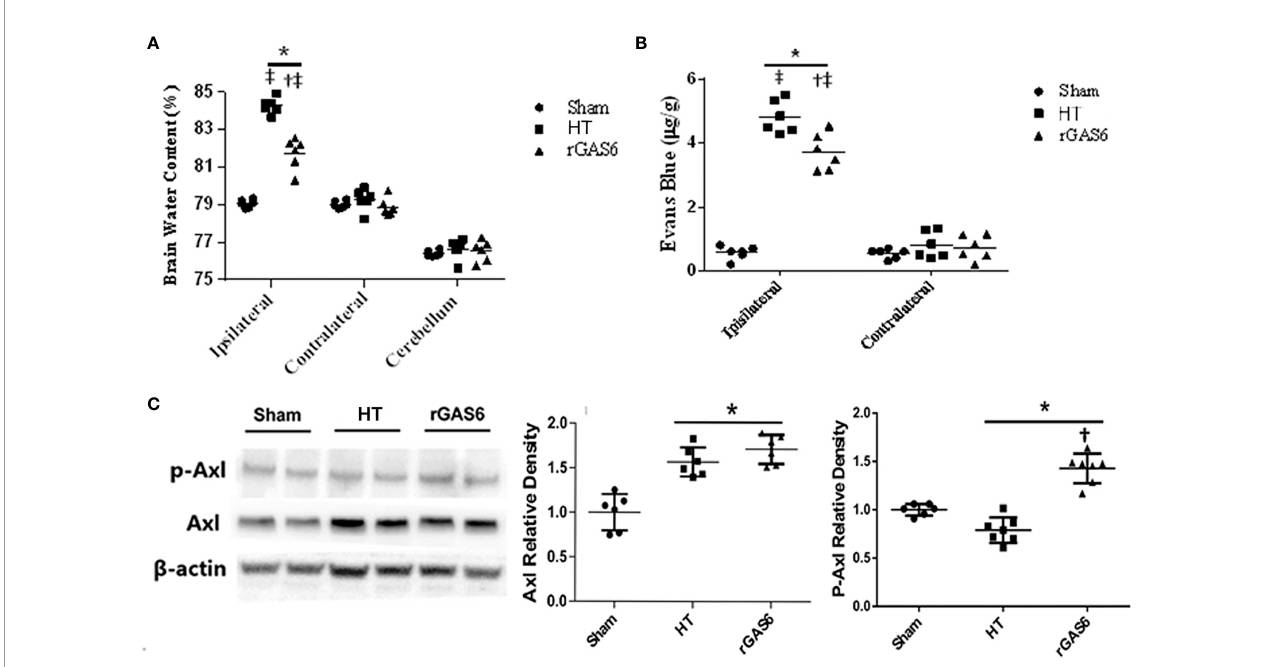
FIGURE 3 | Recombinant GAS6 (rGAS6) treatment reduces brain edema and BBB permeability, as well as enhances Axl phosphorylation (p-Axl). Brain water contents of each group 24 h after MCAO are demonstrated in (A) (each group, n=6). Evans blue contents of each group 24 h after MCAO plus 2 h of administration are shown in (B) (each group, n=6; 24 h after MCAO). Western blot assays for Axl and p-Axl of each group 24 h after MCAO are shown in (C) (each group, n=6). Relative densities of each protein have been normalized to the sham group. * P < 0.05 versus sham; † P < 0.05 versus hemorrhagic transformation (HT); ‡ P < 0.05 versus contralateral hemisphere, one-way analysis of variance followed by Tukey